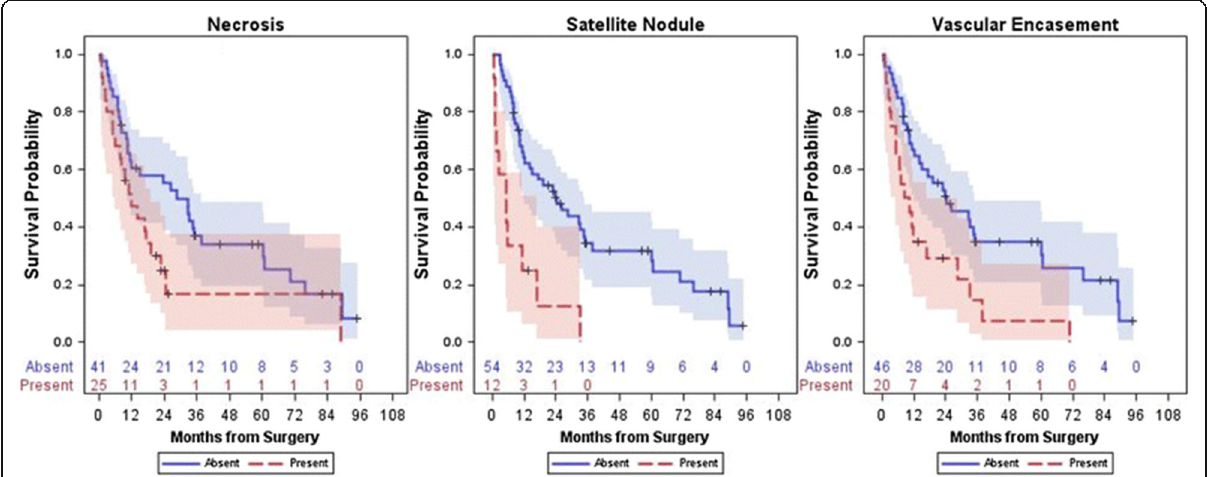
Fig. 6 Kaplan – Meier survival curves which illustrate that the presence of satellite nodules and vascular encasement were associated with decreased disease-free survival. Reprinted with permission from: Aherne EA, Pak LM, Goldman DA, Gonen M, Jarnagin WR, Simpson AL, and Do RK. Intrahepatic cholangiocarcinoma: can imaging phenotypes predict survival and tumor genetics? Abdom Radiol, 2018, 43